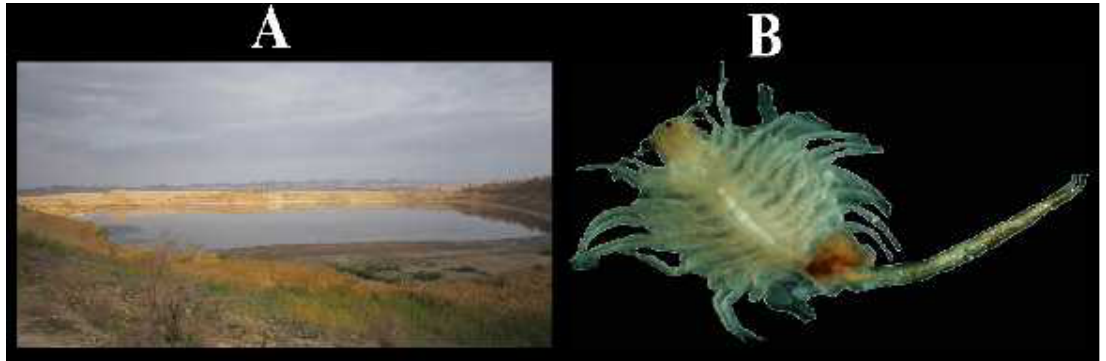
F IGURE 2. A. Current status of Bazangan Lake B. Female Artemia of Bazangan